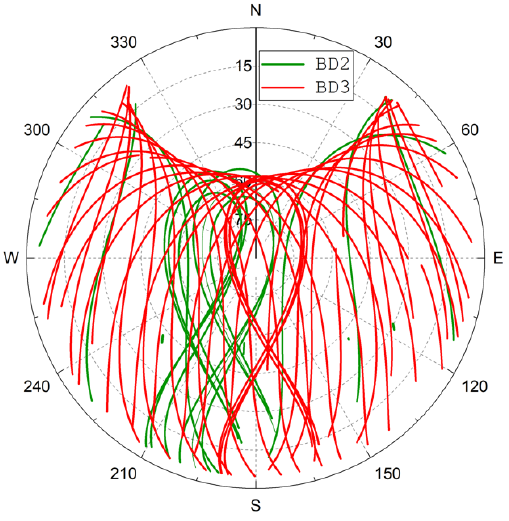
Figure 3. Skyplot map of BDS-2 (green) and BDS-3 (red) satellites at station WH04.